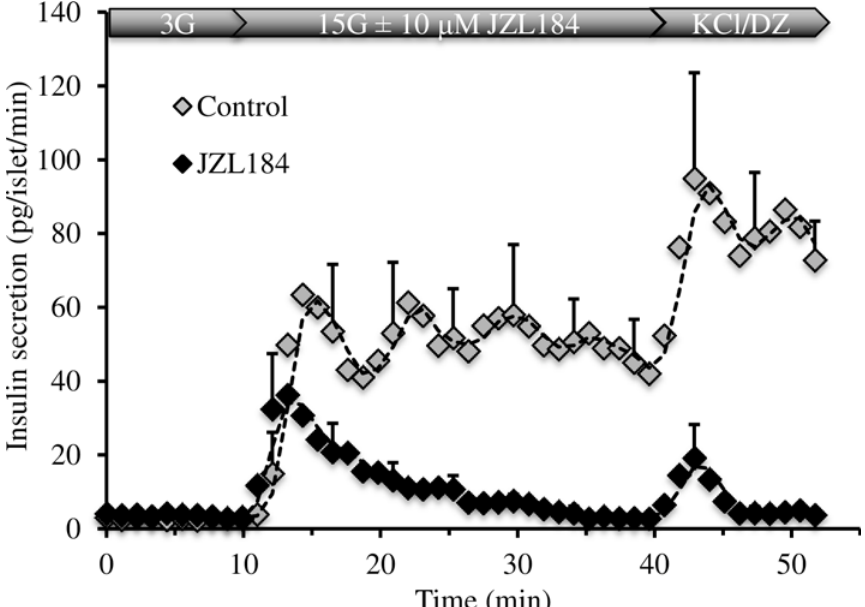
Fig 2. JZL184 reduced sustained insulin secretion during glucose stimulation in whole isolated rat islets. Islets were perifused with basal glucose (3 mM) KRB buffer for approximately 10 minutes followed by a 30-minute perifusion with 15 mM glucose with or without 10 μ M JZL184. At 40 minutes the islets were perifused with 15 mM glucose KRB with 0.4 mM DZ and 30 mM KCl with or without 10 μ M JZL184. n = 3 independent experiments from different islet isolations. Error bars represent S.E. and are displayed every 4 th data point for clarity. All points after 23.1 minutes were significantly different ( p < 0.05).